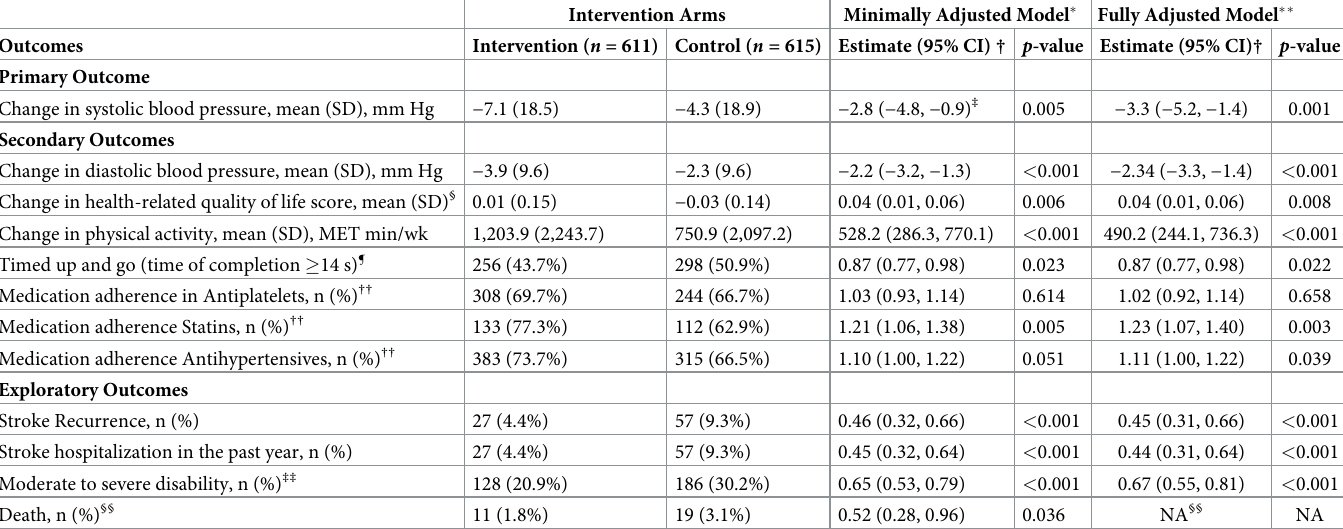
Table 2. Minimally adjusted and fully adjusted results on primary, secondary, and exploratory